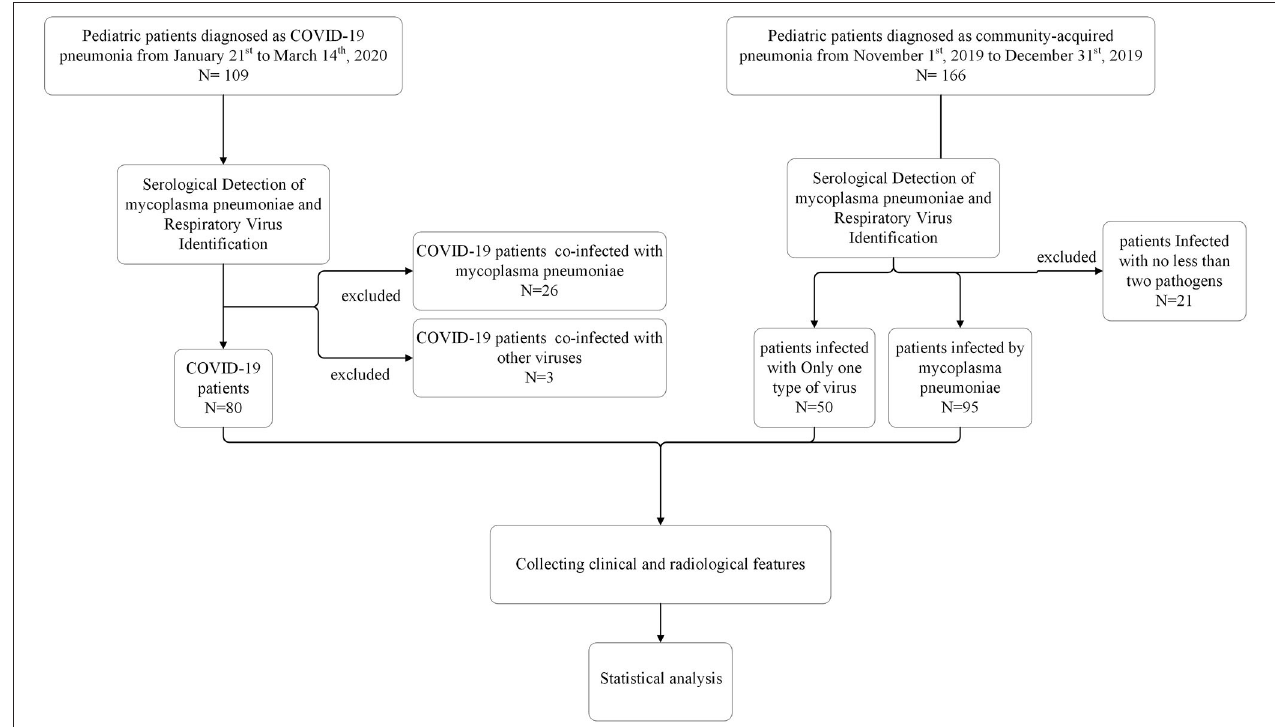
FIGURE 1 | Flow chart for patient selection.